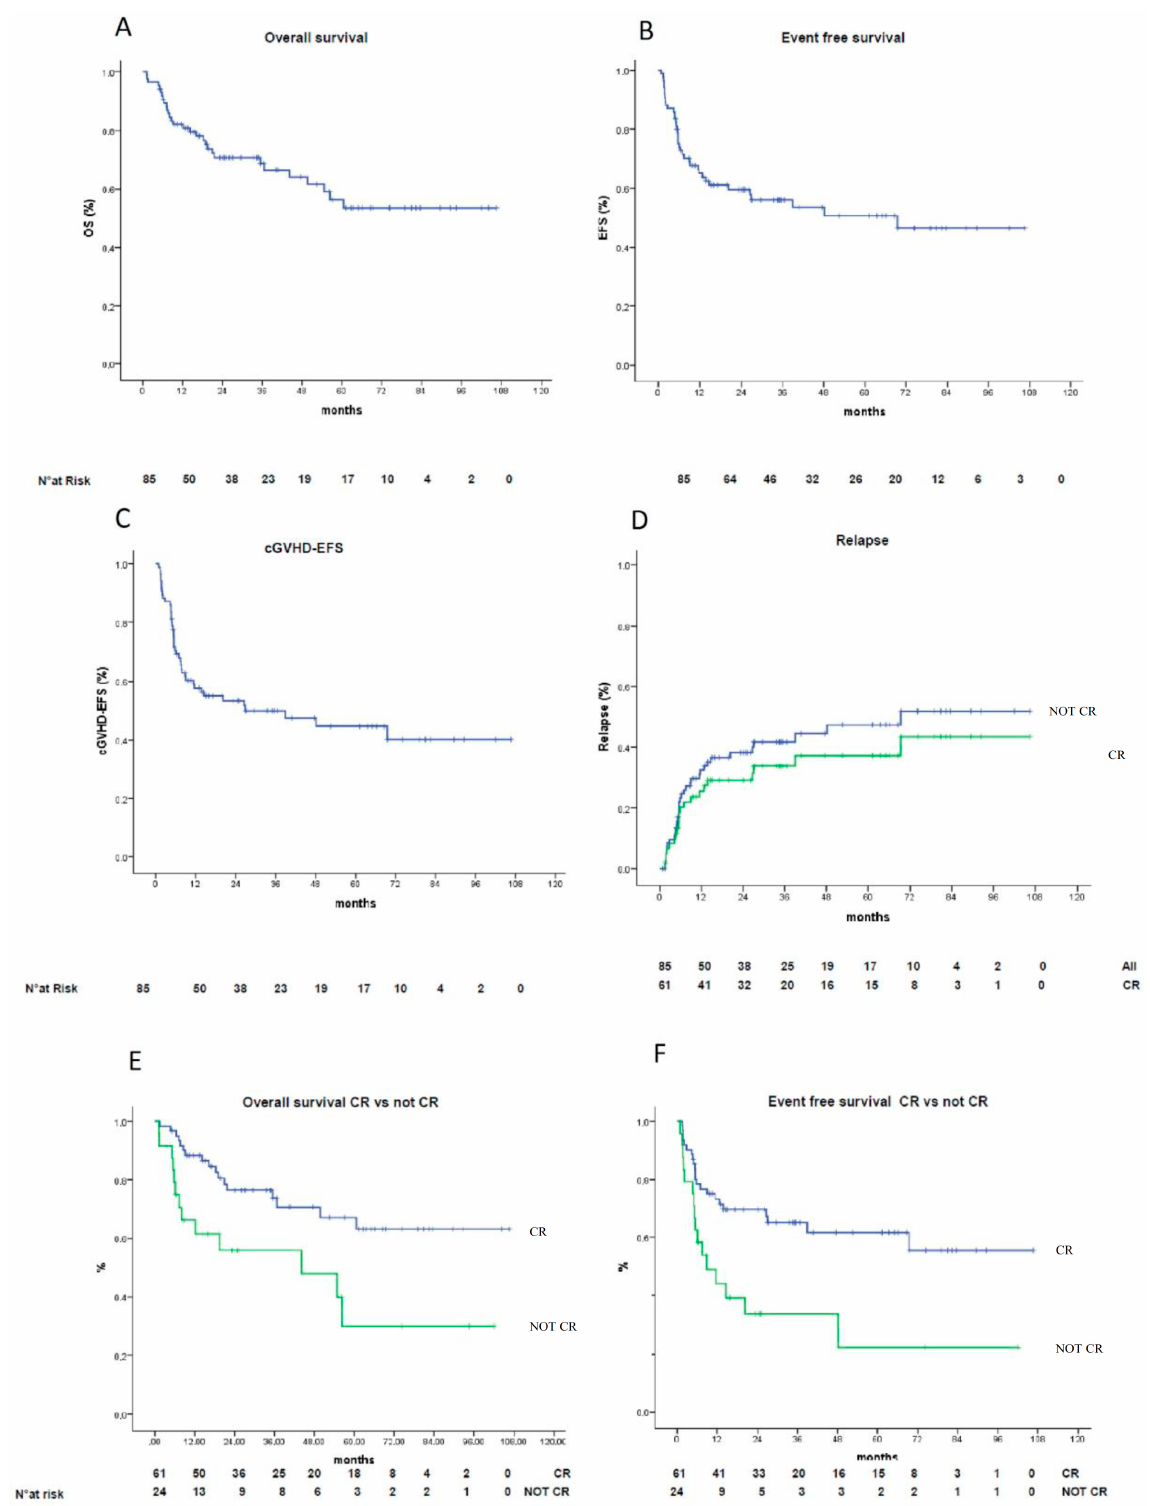
Figure 3. Kaplan–Maier survival curves. ( A ) Overall survival (OS) in the overall population. ( B ) Event-free survival (EFS) in the overall population ( C ) cGVHD-EFS in the overall population, ( D ) Relapse-rate in the overall population (blue line) vs. CR (green line) p = 0.336), ( E ) OS stratified by depth of response (CR (blue line) > not CR (green line), p = 0.008). ( F ) EFS stratified by depth of response (CR (blue line) > not CR (green line), p =